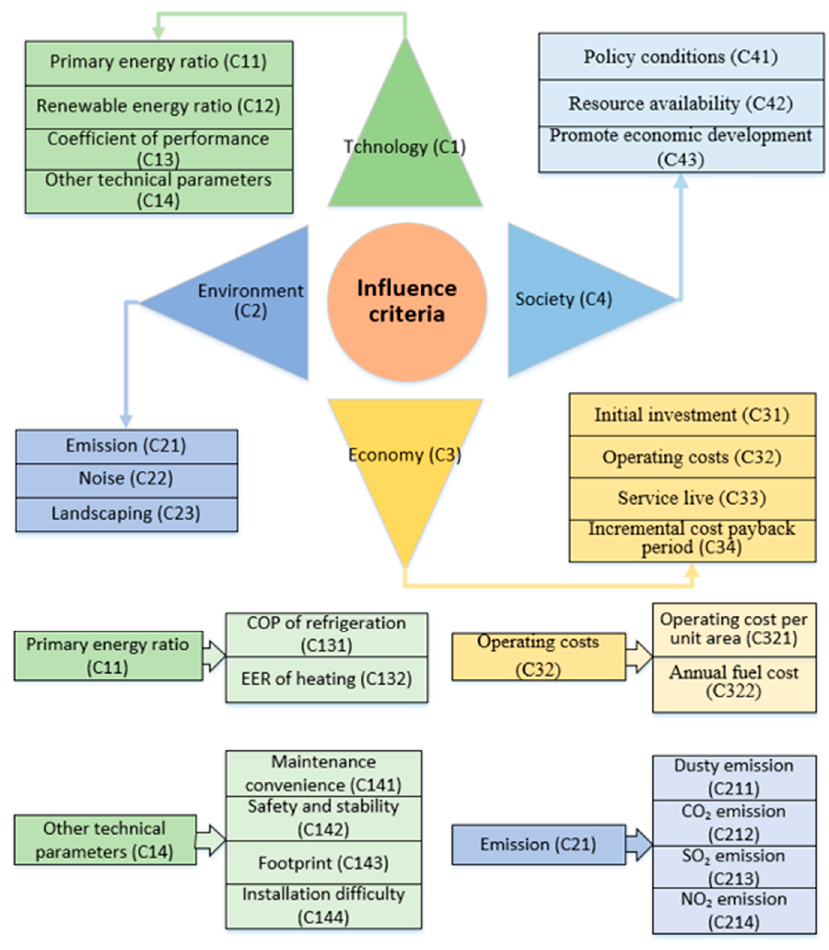
Figure 1. Evaluation criteria of Distributed Energy System (DES).